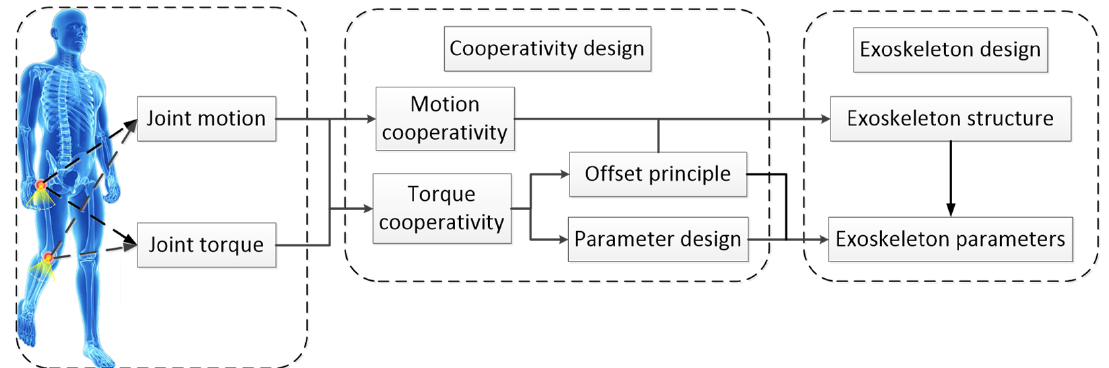
Figure 1. Process of the cooperativity model.